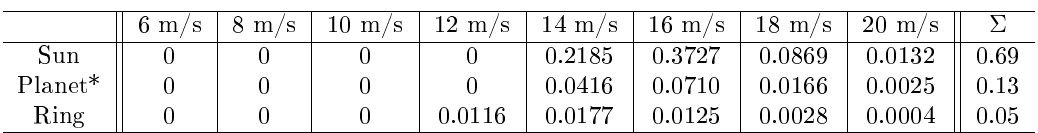
Table 7: Example of accumulated fatigue damage using TI=10% (* means average of 3 planets).